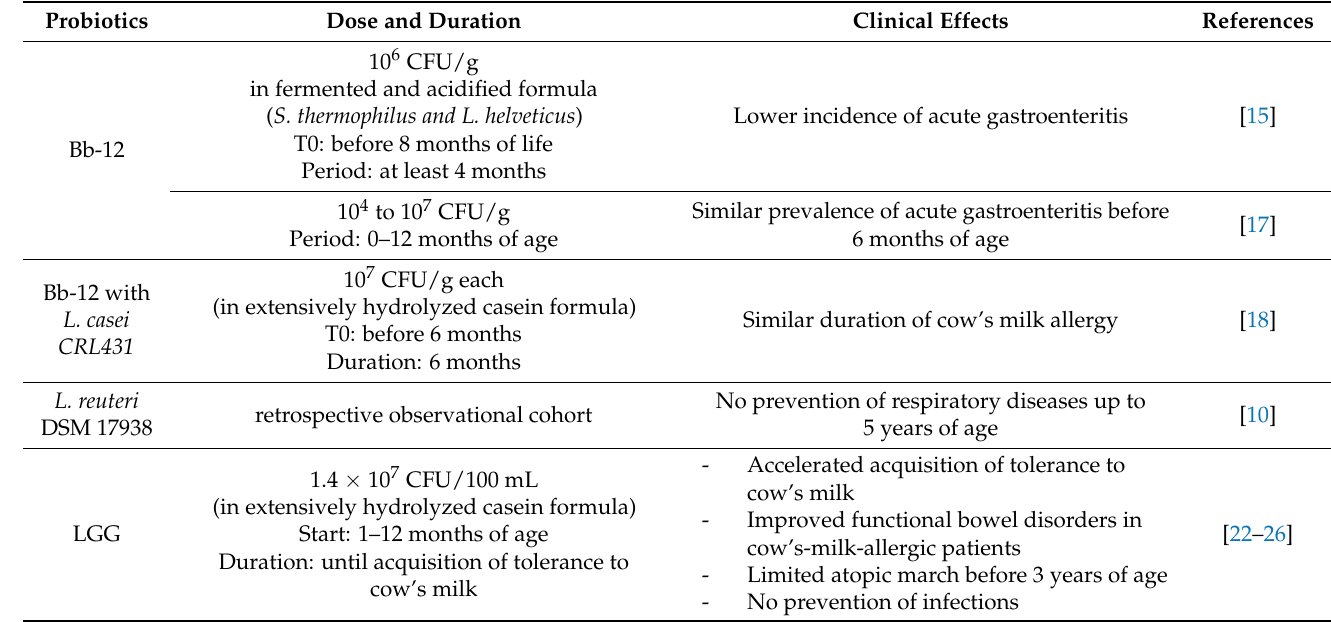
Table 1 summarizes the main clinical effects of probiotics in infant formula. Table 1. Summary of clinical effects of probiotics compared to control groups with non-supplemented infant